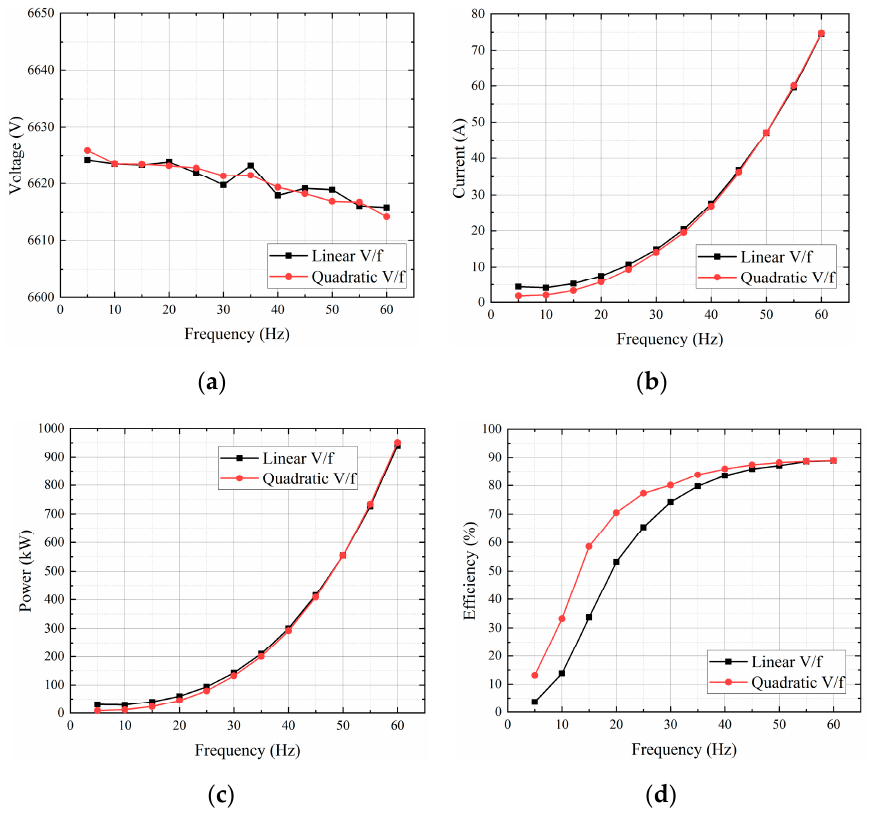
Figure 6. Performance curves measured at the input terminals of multi-level inverter according to linear and quadratic V/f controls. ( a ) Line to line voltages curves; ( b ) phase current curves; ( c ) power curves; ( d ) efficiency curves of EMDS.